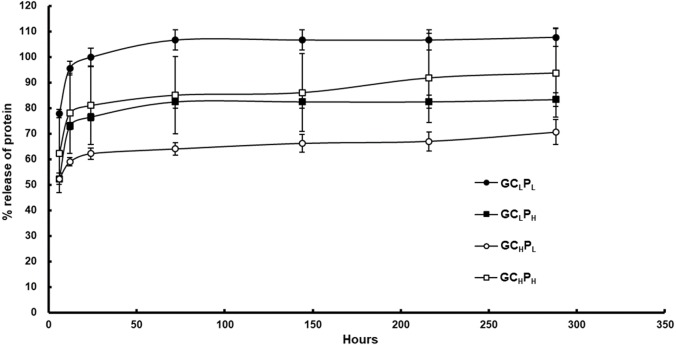
Cumulative protein release from G/C/P biocomposites in PBS at 37 °C.